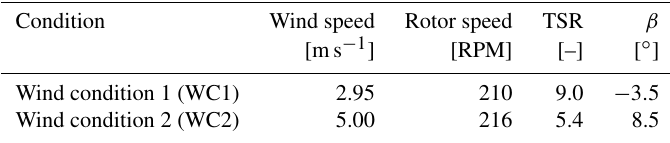
Table 2. Wind turbine operating conditions considered in the experiment ( β is collective